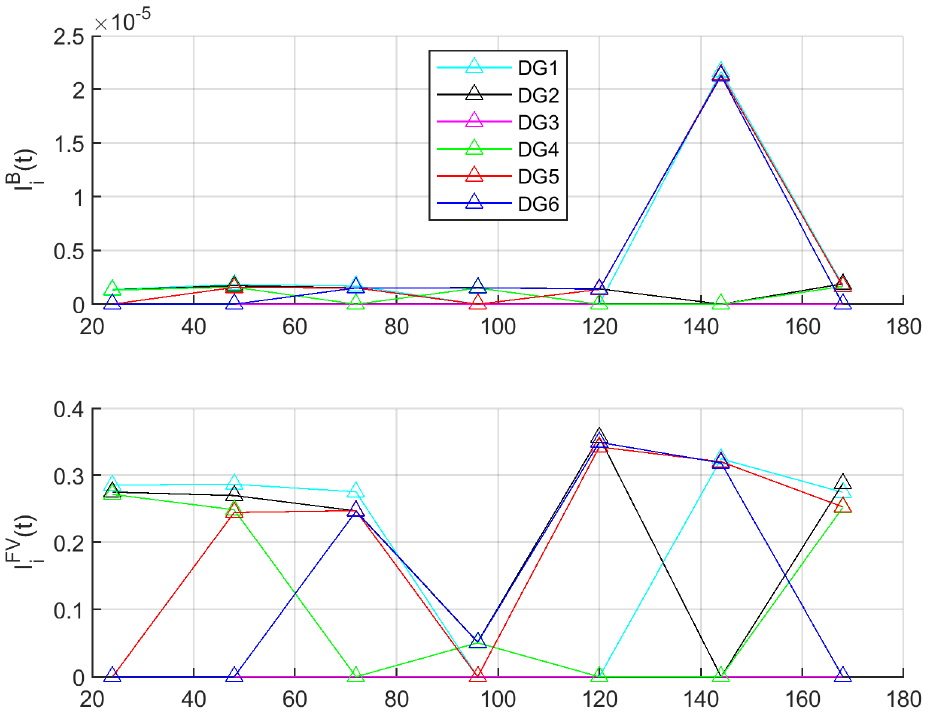
Figure 5. (cid:1835) (cid:3036)(cid:3003) ((cid:1872)) and (cid:1835) (cid:3036)(cid:3007)(cid:3023) ((cid:1872)) for the connected DG sets (horizontal axis is in hours). (Note: importance measures points are connected with lines for facilitating the results visualisation.)